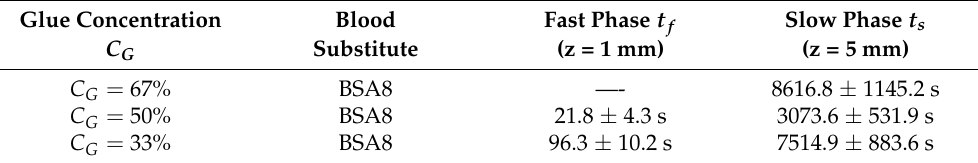
Figure 5. Time evolution of intensity change in C=C during the fast ( a ) and slow ( b ) polymerization phases of GO mixtures in contact with blood substitute BSA8. Table 1. Characteristic polymerization time of fast and slow phases ( t f and t s ) for GO mixtures in contact with